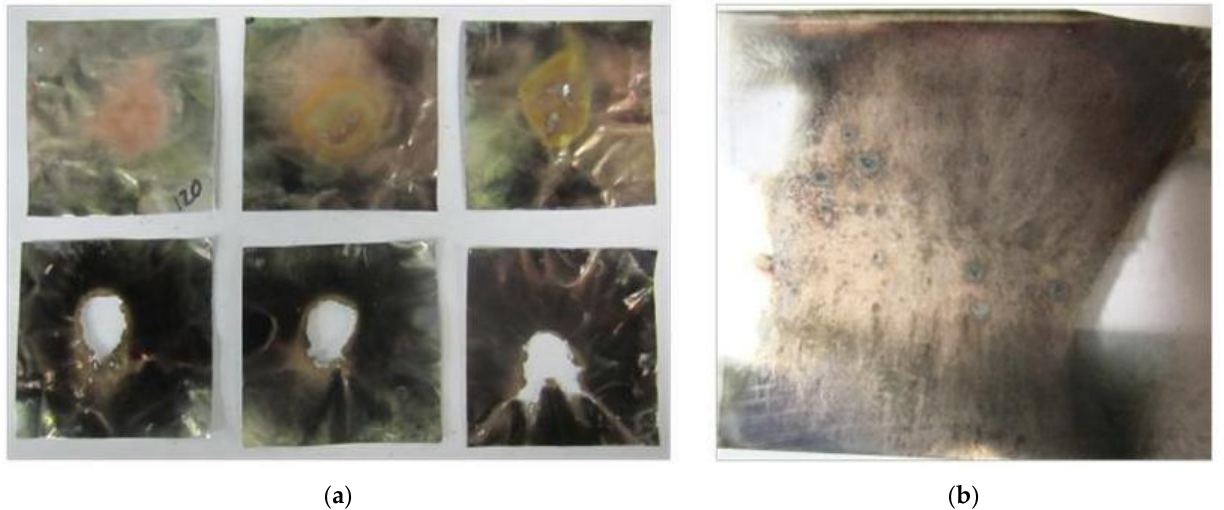
Figure 5. The photographic evidence of an impact of the frontal flow of combustion products. ( a ) The impact of mixture weighing 0.3 g on a 0.15 mm thick aluminium foil for distances of 120, 90, 60, 52, 45 and 30 mm (from left to right and from top to bottom), respectively. ( b ) Spots of interaction of the flow of reacting particles on a 0.3 mm thick polycarbonate target film. Photographic recording was not carried out in these experiments.